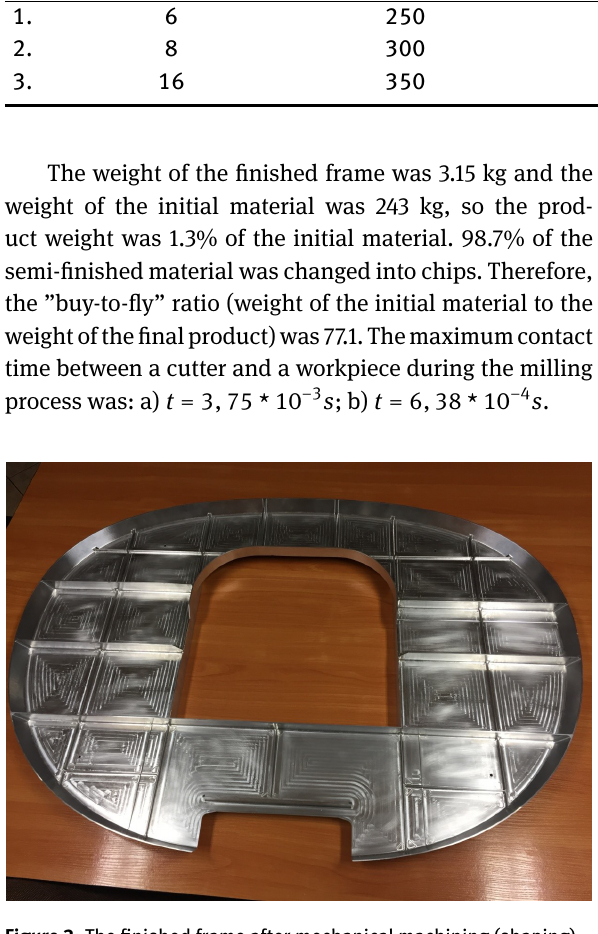
Figure 3: The finished frame after mechanical machining (shaping)